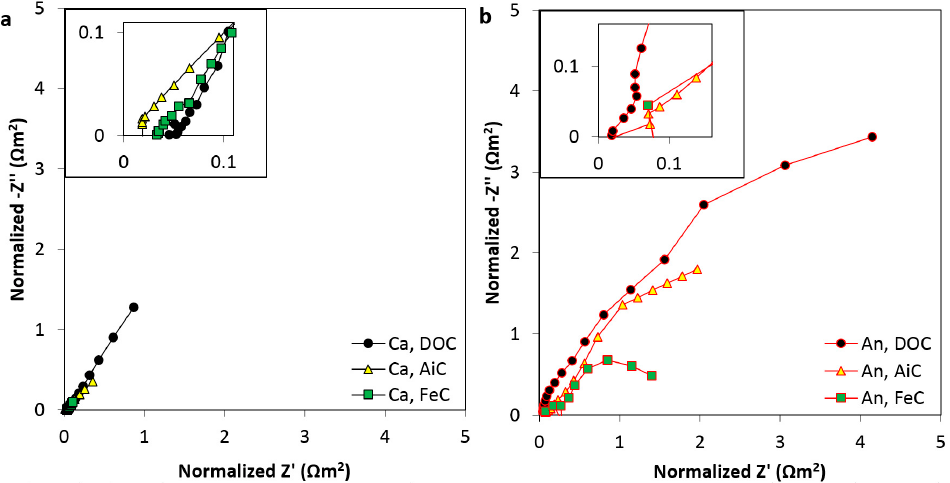
Figure 4. Electrochemical impedance spectroscopy (EIS) spectrum of the ( a ) cathode and ( b ) anode as the normalized imaginary impedance ( Z ”) vs. the normalized real impedance ( Z ’). The inserted plots show the data at low Z ’ used for estimation of the ohmic resistance. Table 1. Ohmic resistance obtained from the EIS spectra of the three cathode types: DOC, FeC and AiC in Figure 3. Data are compared with internal resistance estimated by linear regression using Figures 2a and 3.